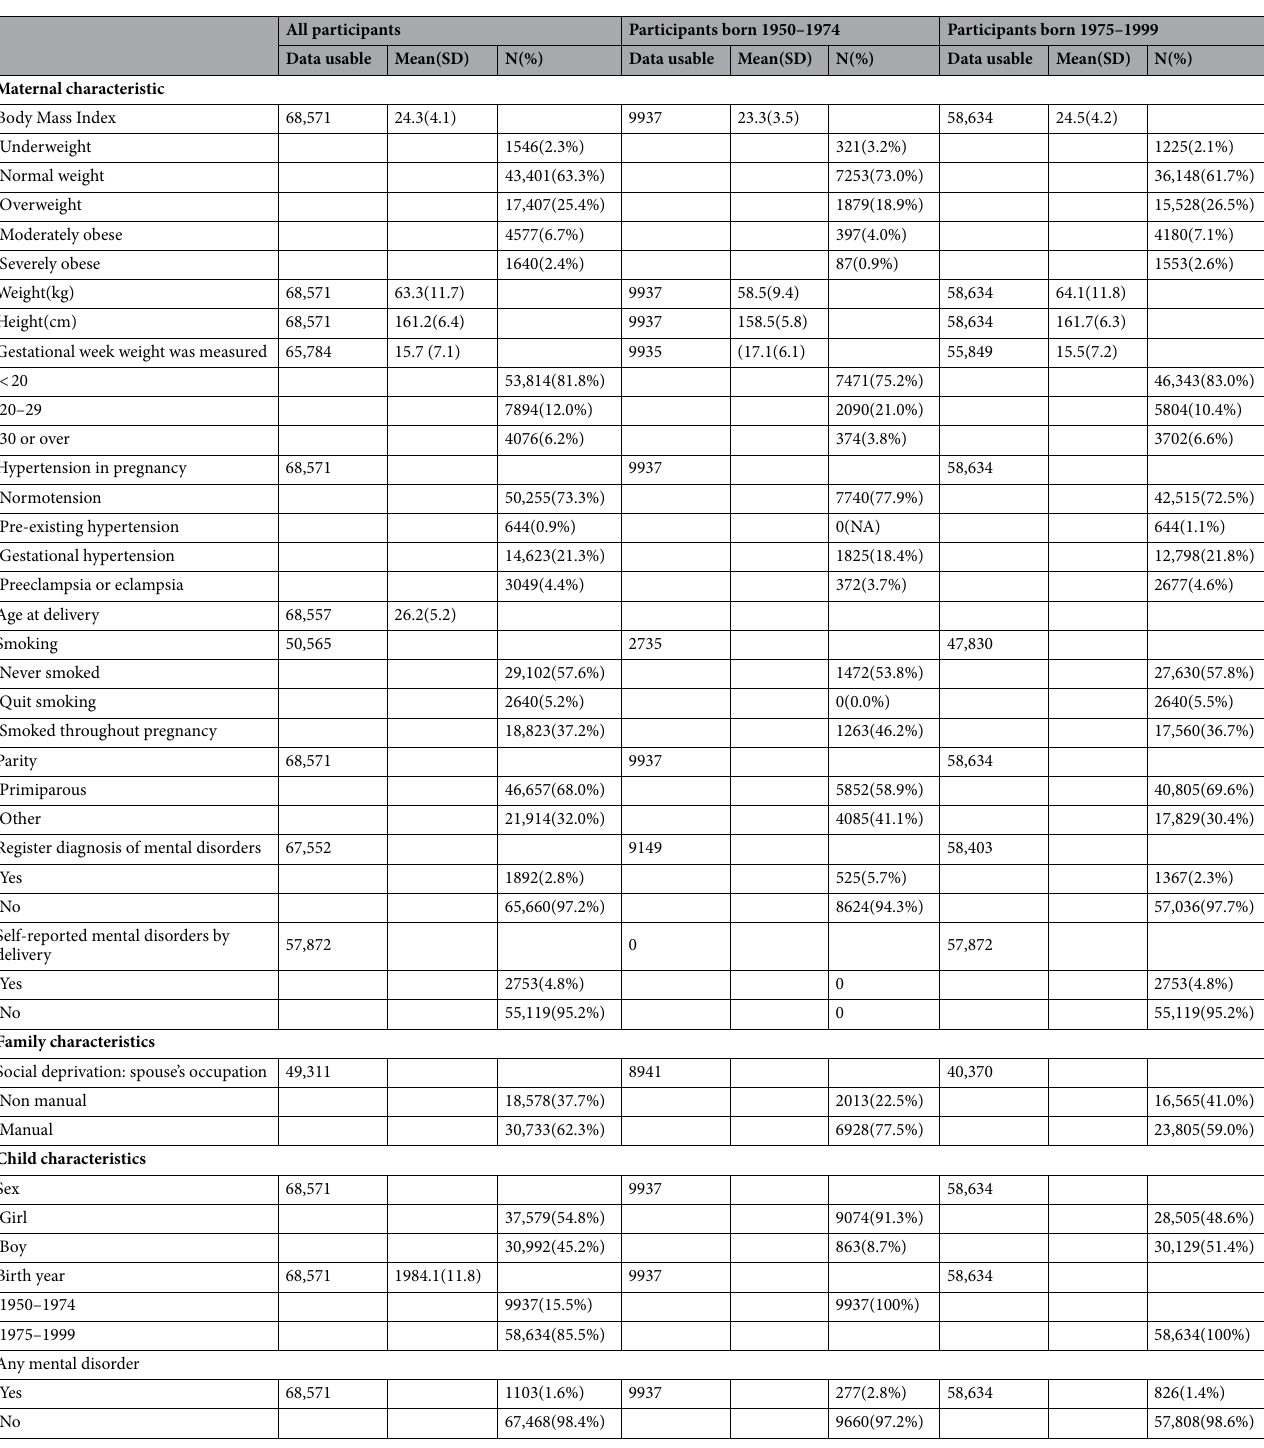
Table 1. Characteristics of the whole study sample and of participants born 1950–1974 and 1975– 1999. All p-values for differences between the birth year groups in the maternal, perinatal and child characteristics < .001. SD standard deviation; NA not available; kg kilogram; cm